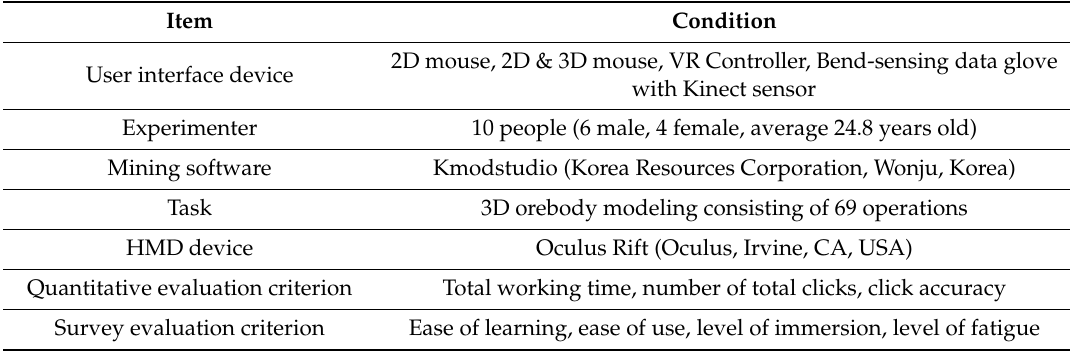
Table 1. Experimental conditions and evaluation criteria related to user interface devices, experimenter, software, and the head mounted display (HMD) device.